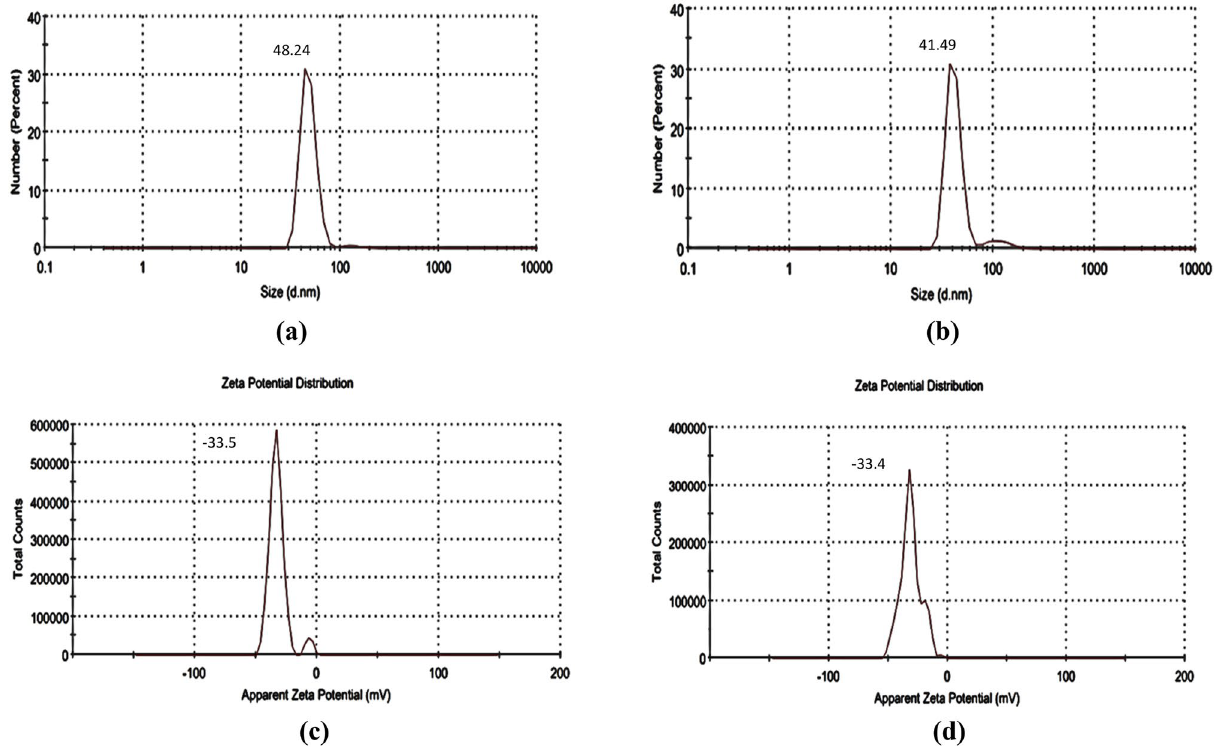
Figure 16. Size ( a ) & surface charge ( c ) of synthesized iron nanoparticles before employing the optimized conditions. Size ( b ) & surface charge ( d ) of synthesized iron nanoparticles after employing the optimized conditions.